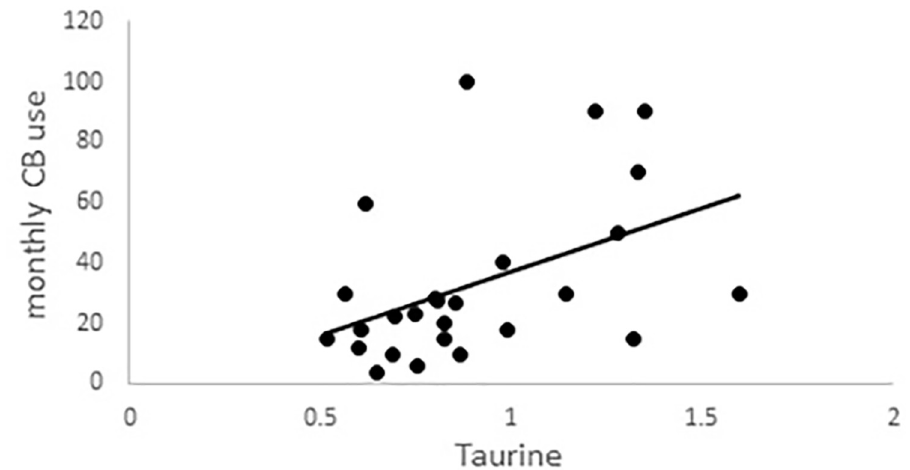
Fig 1. Expt 1 results. Correlation between taurine and monthly CB use in the CB user group.